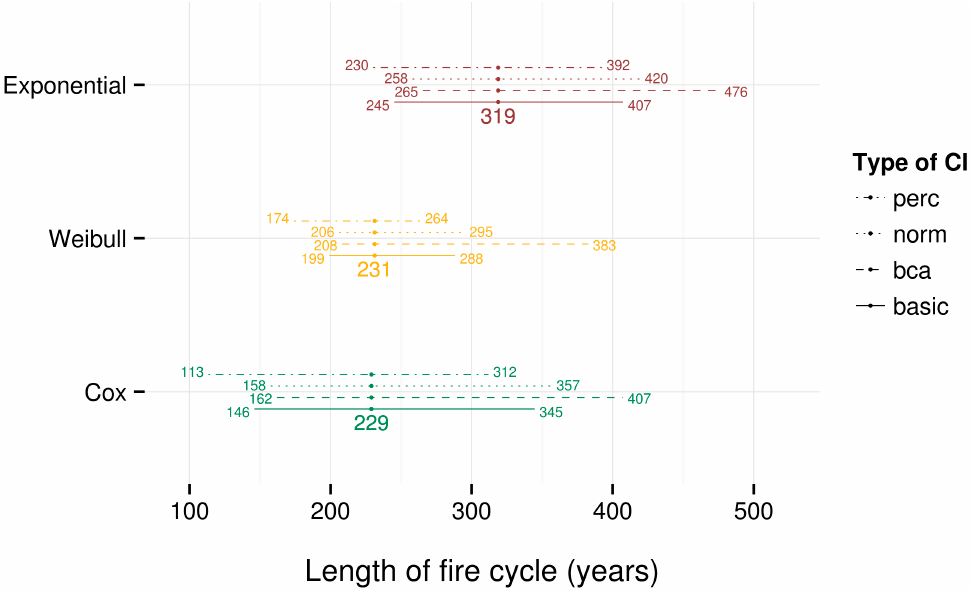
Figure 8. Fire cycle estimates and CI95 for the Côte-Nord case study area, eastern Canada.